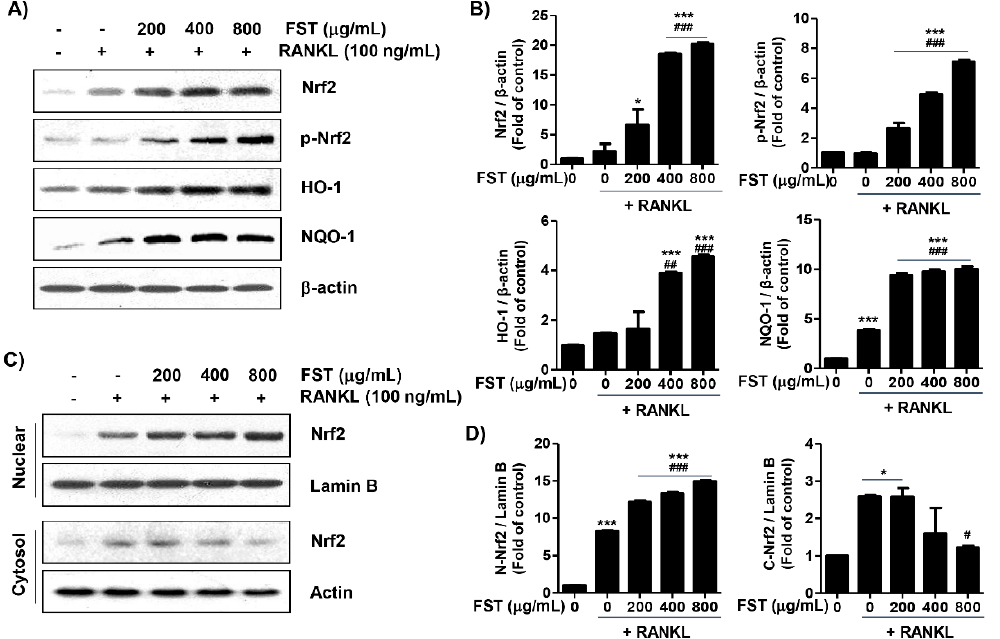
Figure 7. Activation of Nrf2 signaling pathway by FST in RAW 264.7 mouse macrophage-like cells. Cells were treated with FST with or without 100 ng / mL RANKL for 5 days. ( A ) Total cellular proteins were isolated from cells and the expression levels of Nrf2 and its regulatory proteins were assessed by Western blot analysis. β -actin was used as the internal control. ( C ) The expression of nuclear and cytosol Nrf2 were determined by Western blotting. Lamin B and β -actin were used as internal controls for the nuclear and cytosolic fractions, respectively. The results shown are representative of three independent experiments. ( B , D ) Statistical analyses were conducted using analysis of variances between groups. * p < 0.05 and *** p < 0.0001 when compared to control. # p < 0.05 and ### p < 0.0001 when compared to RANKL treatment. RANKL: receptor of activator of nuclear factor kappa-B ligand;